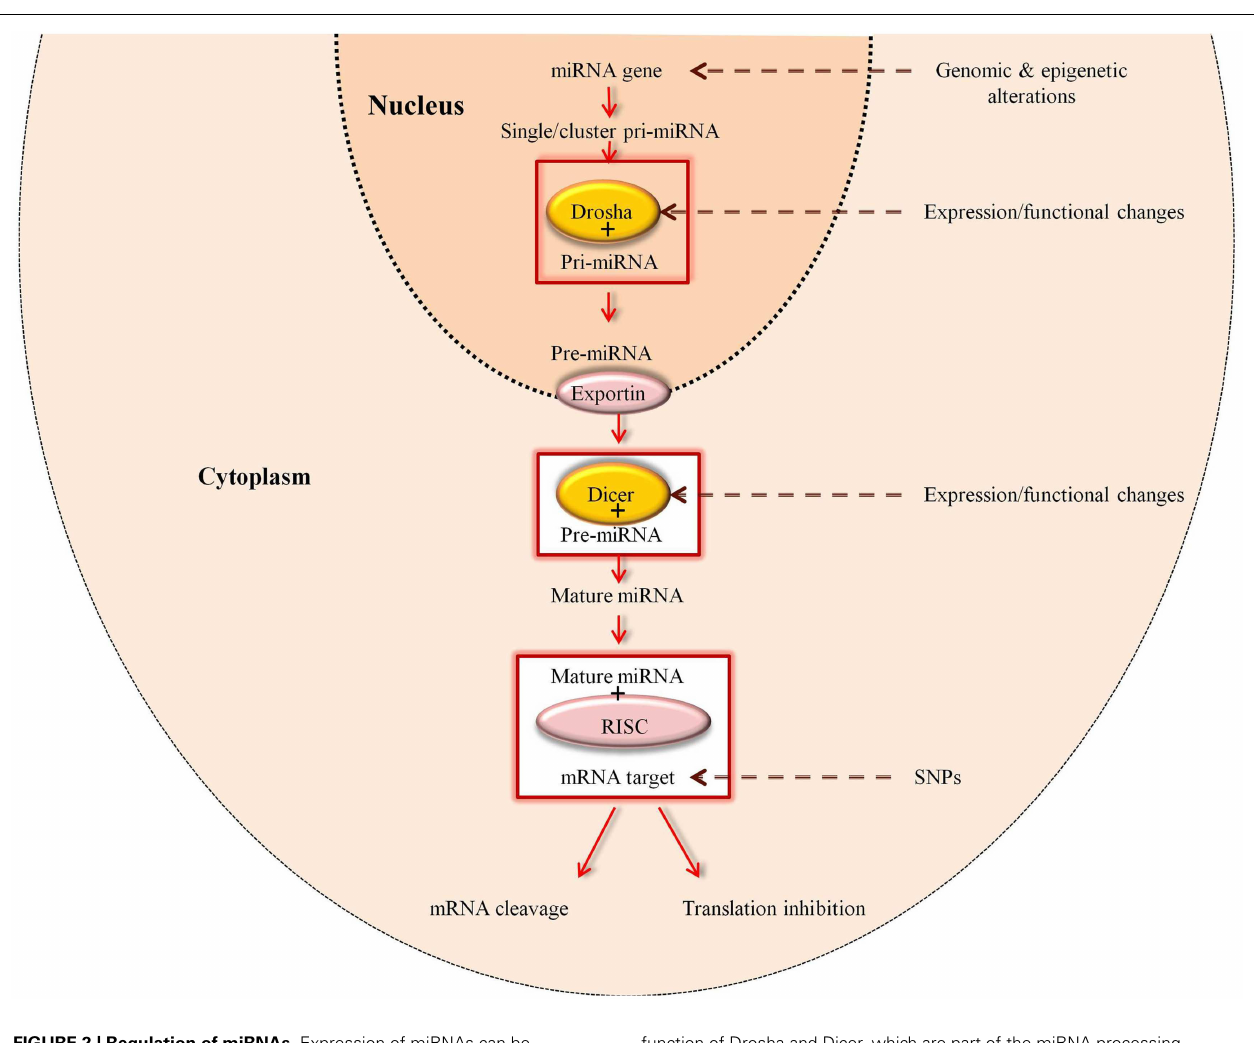
FIGURE 2 | Regulation of miRNAs . Expression of miRNAs can be altered at various stages of its biogenesis by genomic (SNPs and mutations) and epigenetic alterations. Changes in the expression and